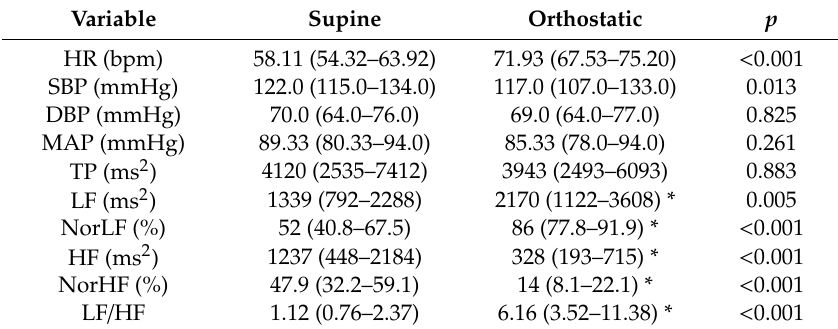
Table 2. Median and interquartile range (25–75%) of the hemodynamic parameters and the Heart Rate Variability in the supine and orthostatic